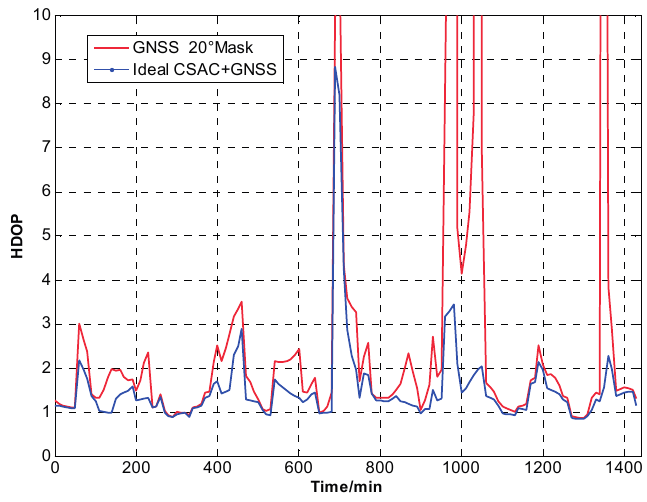
Figure 11. PDOP comparison at 20° cutoff.